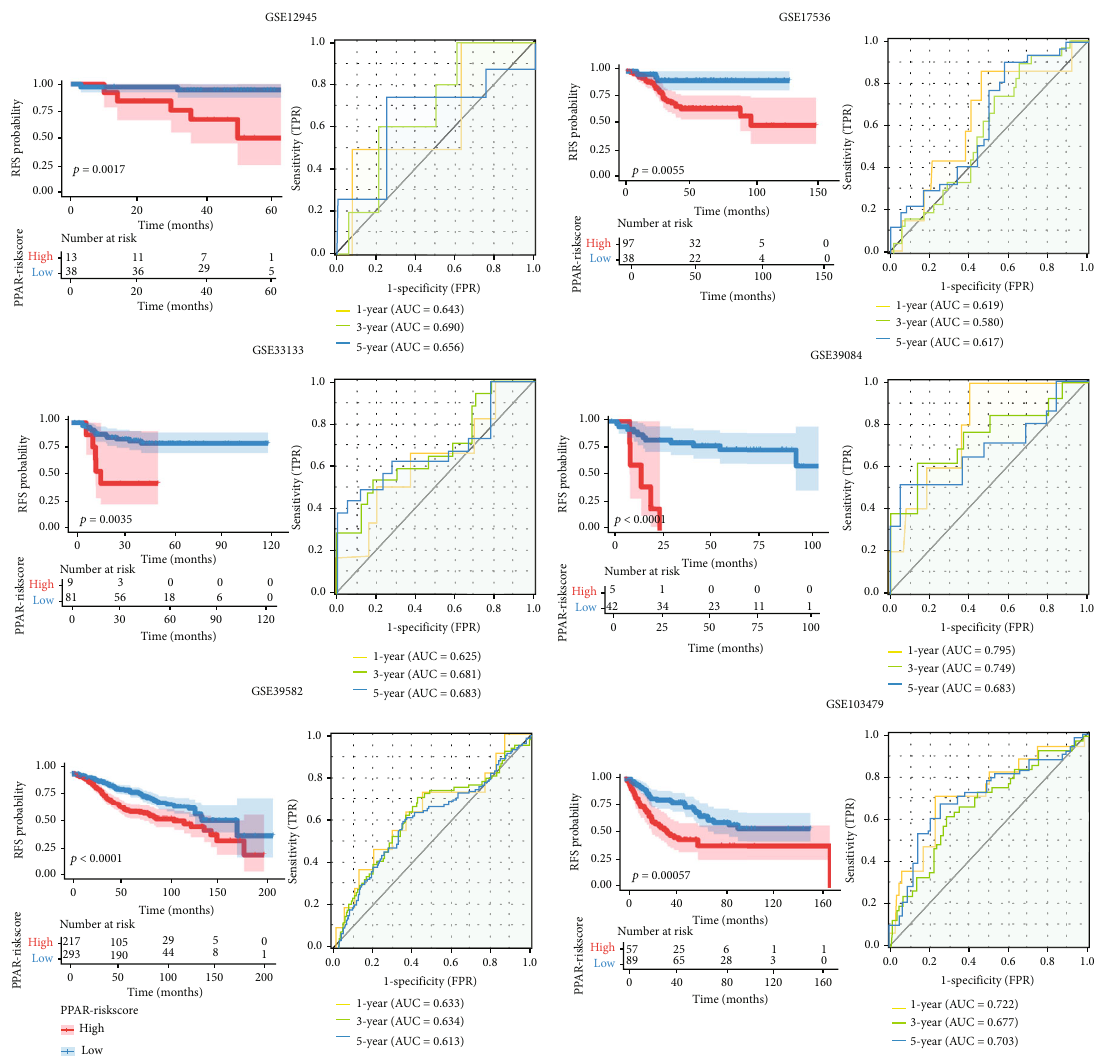
Figure 4: Results of PPAR-Riskscore external validation utilizing six microarray cohorts. Based on the value of PPAR-Riskscore, each cohort was separated equally into high-risk and low-risk groups. Each cohort ’ s Kaplan-Meier analysis and time-dependent receiver operating characteristic curves are